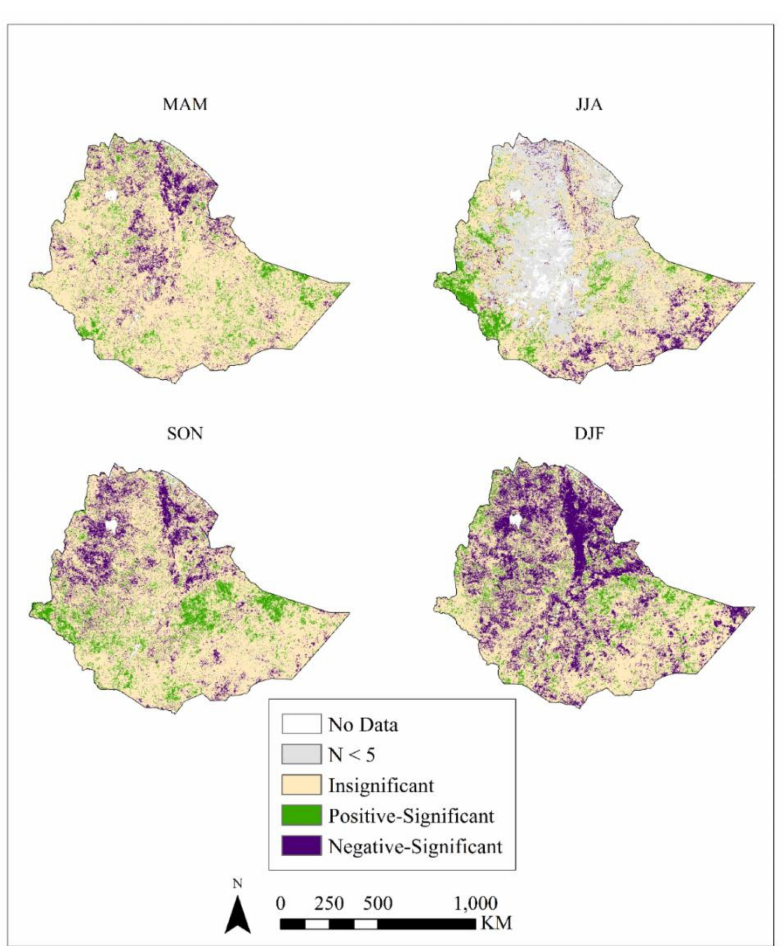
Figure 2. Spatial distributions of directional persistence outcomes by season in Ethiopia. Seasons are divided into 3-month periods: March–May (MAM), June–August (JJA), September–November (SON), and December–February (DJF).